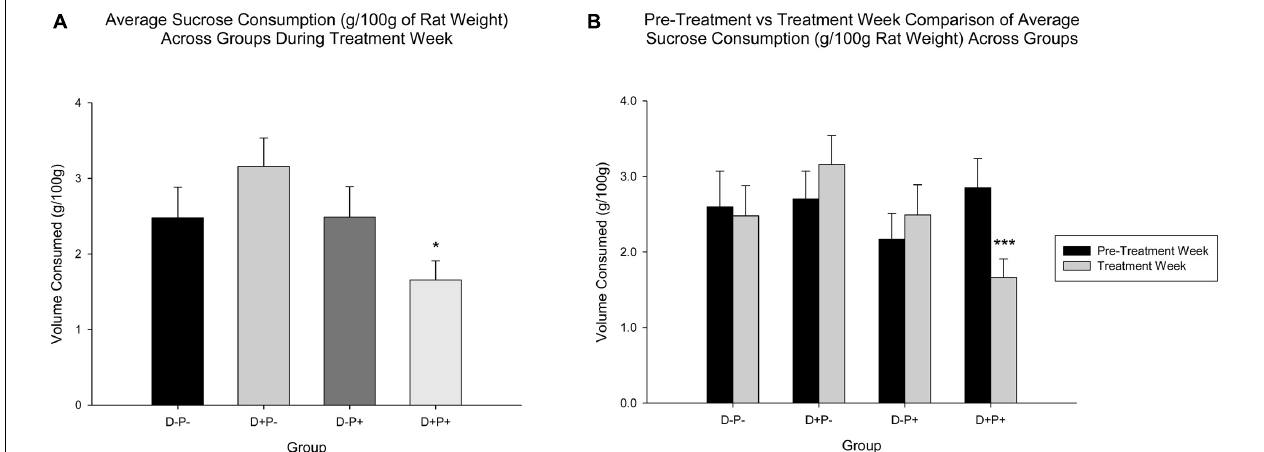
FIGURE 6 | (A) Average sucrose consumption (g/100 g rat weight) during treatment week. Sucrose consumption was significantly reduced only in the pregnancy termination group (D + P + ) relative to the D + P- group. n = 19–21 rats/group; ∗ p < 0.05. (B) Average sucrose consumption (g/100 g rat weight) in pre-treatment vs. treatment week. The D + P + group was the only group with a significant reduction in average sucrose consumption, during treatment week relative to pre-treatment week. n = 15–17 rats/group; ∗∗∗ p < 0.001. Data is expressed as mean ± SEM.